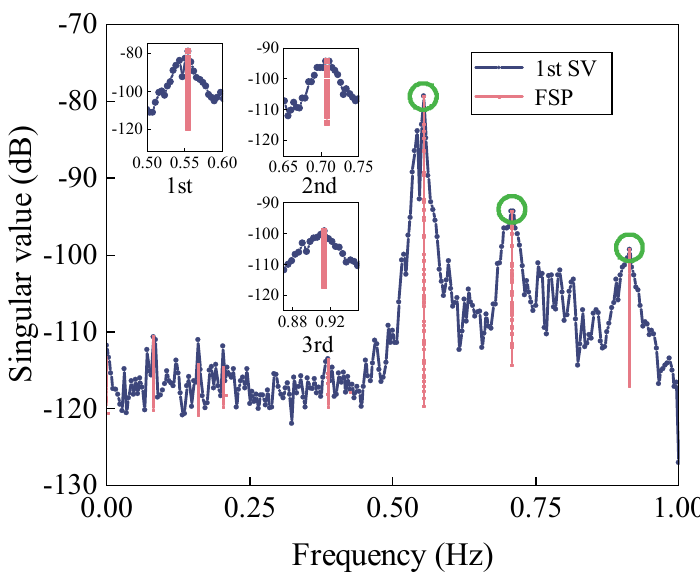
Figure 18. 1st SV spectrum after FSP.